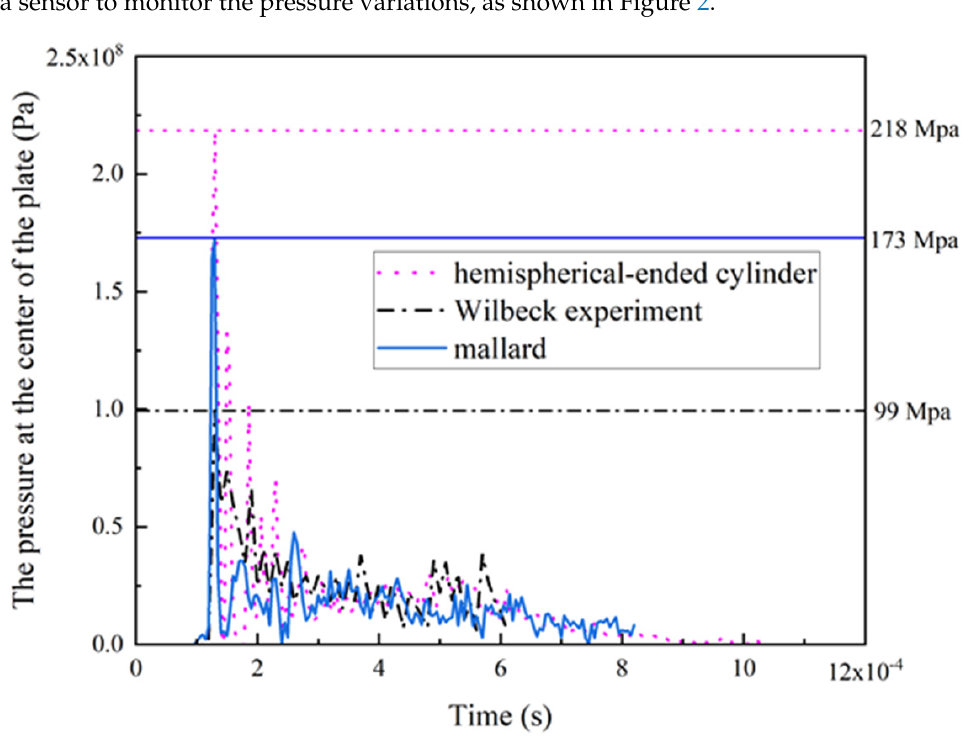
Table 2. Parameters used in Gruneisen EOS for the mallard bird model [11].